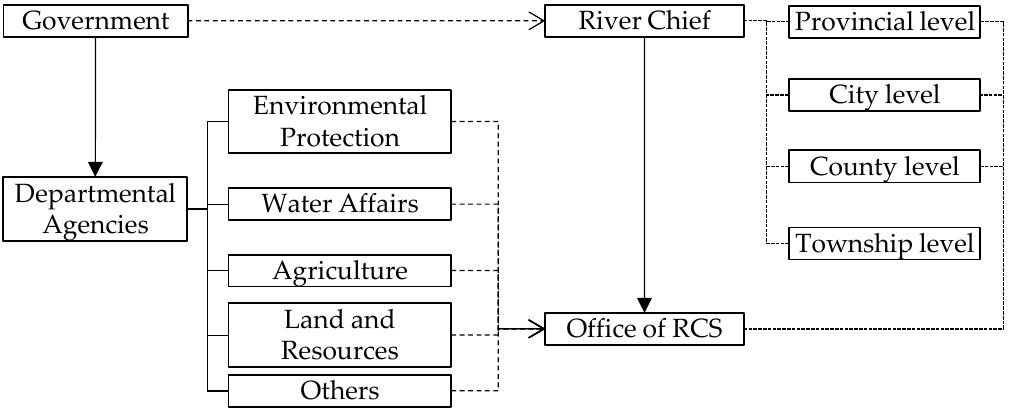
Figure 1. Correspondence between the administrative structure and river chief system (RCS). (Dotted line with an arrow shows the correspondence. The river chiefs of different levels should be senior government officials on the corresponding levels. The office of RCS consists of department agencies on the corresponding levels. Line with an arrow shows the flow of authority.).